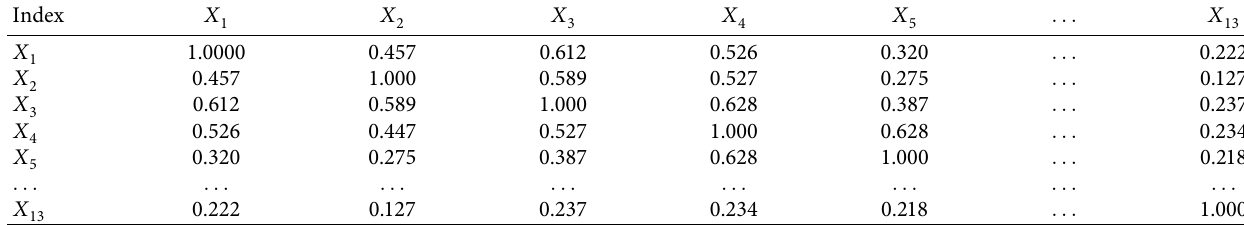
Table 2: Correlation coefficient matrix of the original index.